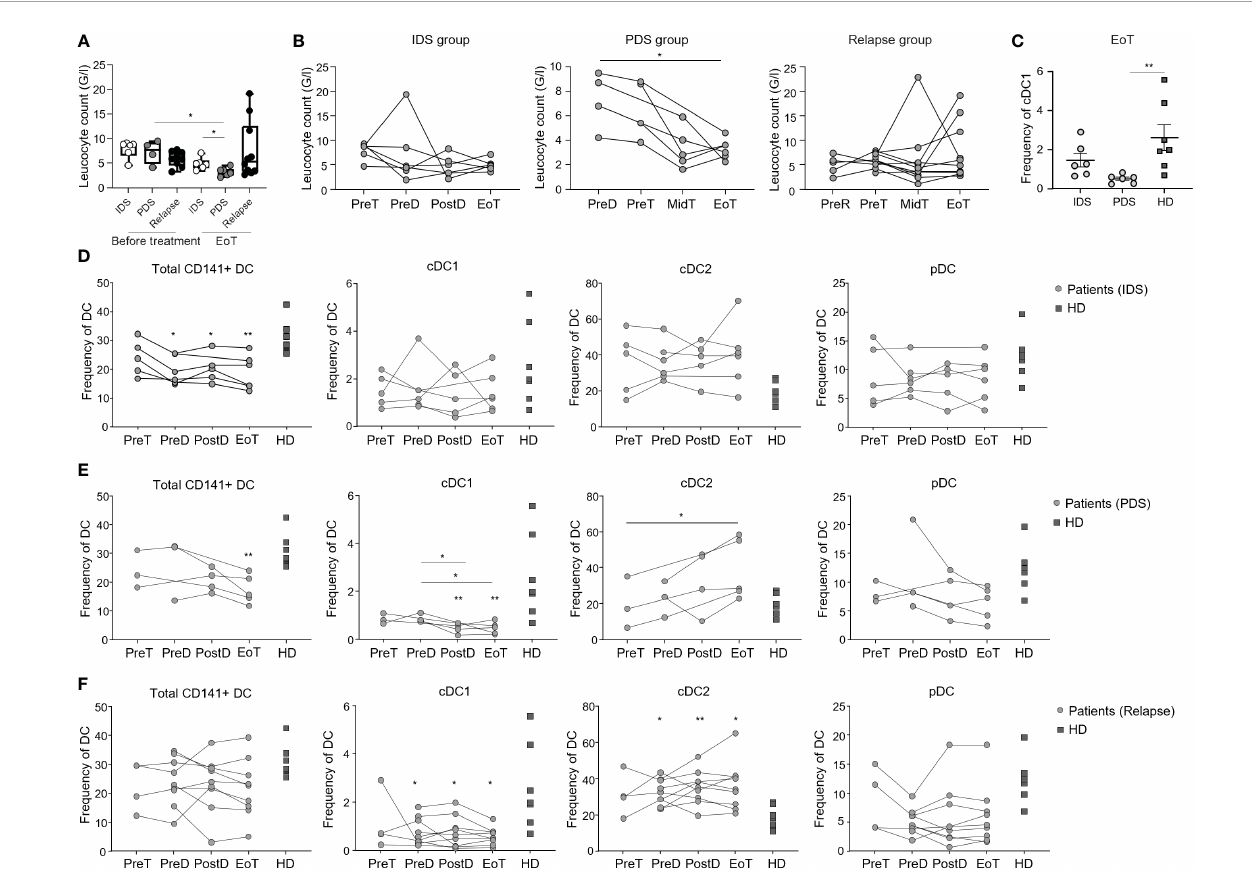
FIGURE 1 Longitudinal monitoring of lymphocytes and DC populations in patients with OvC and HD. (A) Lymphocyte counts in patients with OvC measured at recruitment or at the end of treatment (EoT). White dots represent patients undergoing IDS regimen, grey dots represent patients undergoing PDS regimen, while black dots represent relapsing patients. The box encompasses the interquartile range, the central band indicates the median, and the whiskers reach the minimum and maximum values. (B) Lymphocyte counts in patients with OvC measured at recruitment, during treatment and at EoT. (C) Frequency of cDC1 in patients with OvC belonging to IDS or PDS groups at the end of treatment and in HD. Cumulative data of the frequency of DC subsets in HD (dark grey squares) and in patients with OvC (grey dots) belonging to (D) IDS group, (E) PDS group and (F) relapse group. * p < 0.05, ** p < 0.01. One-way ANOVA tests followed by pairwise Dunn ’ s